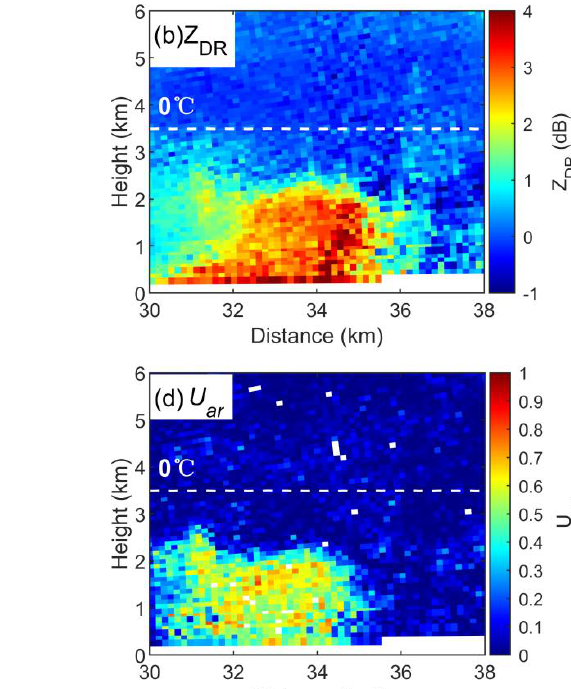
Figure 13. PPI and RHI of Z H at subsequent time intervals. ( a ) PPI at 18:53 LST, ( b ) RHI at 18:55.